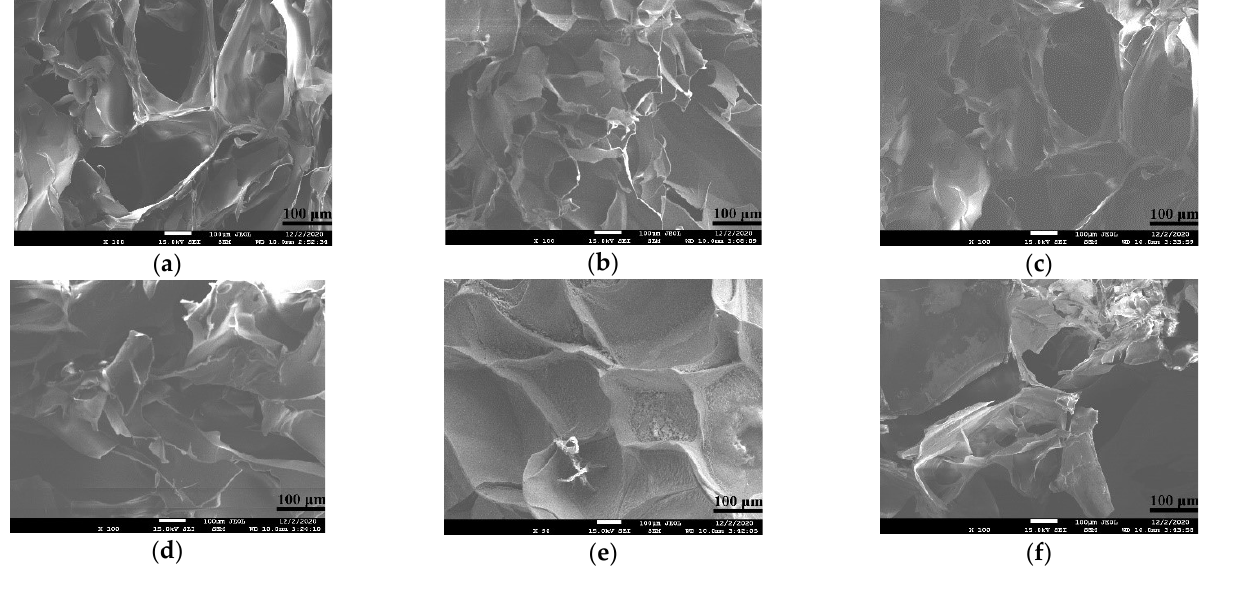
Figure 2. Scanning electron microscope images of the optimal hydrogels prepared in Table 1 after freeze-drying: ( a ) micropore structure of the G-A hydrogel; ( b ) micropore structure of the G-A-A hydrogel; ( c ) micropore structure of the F-A hydrogel; ( d ) micropore structure of the F-A-A hydrogel; ( e ) micropore structure of the A hydrogel; ( f ) micropore structure of the A-A hydrogel.